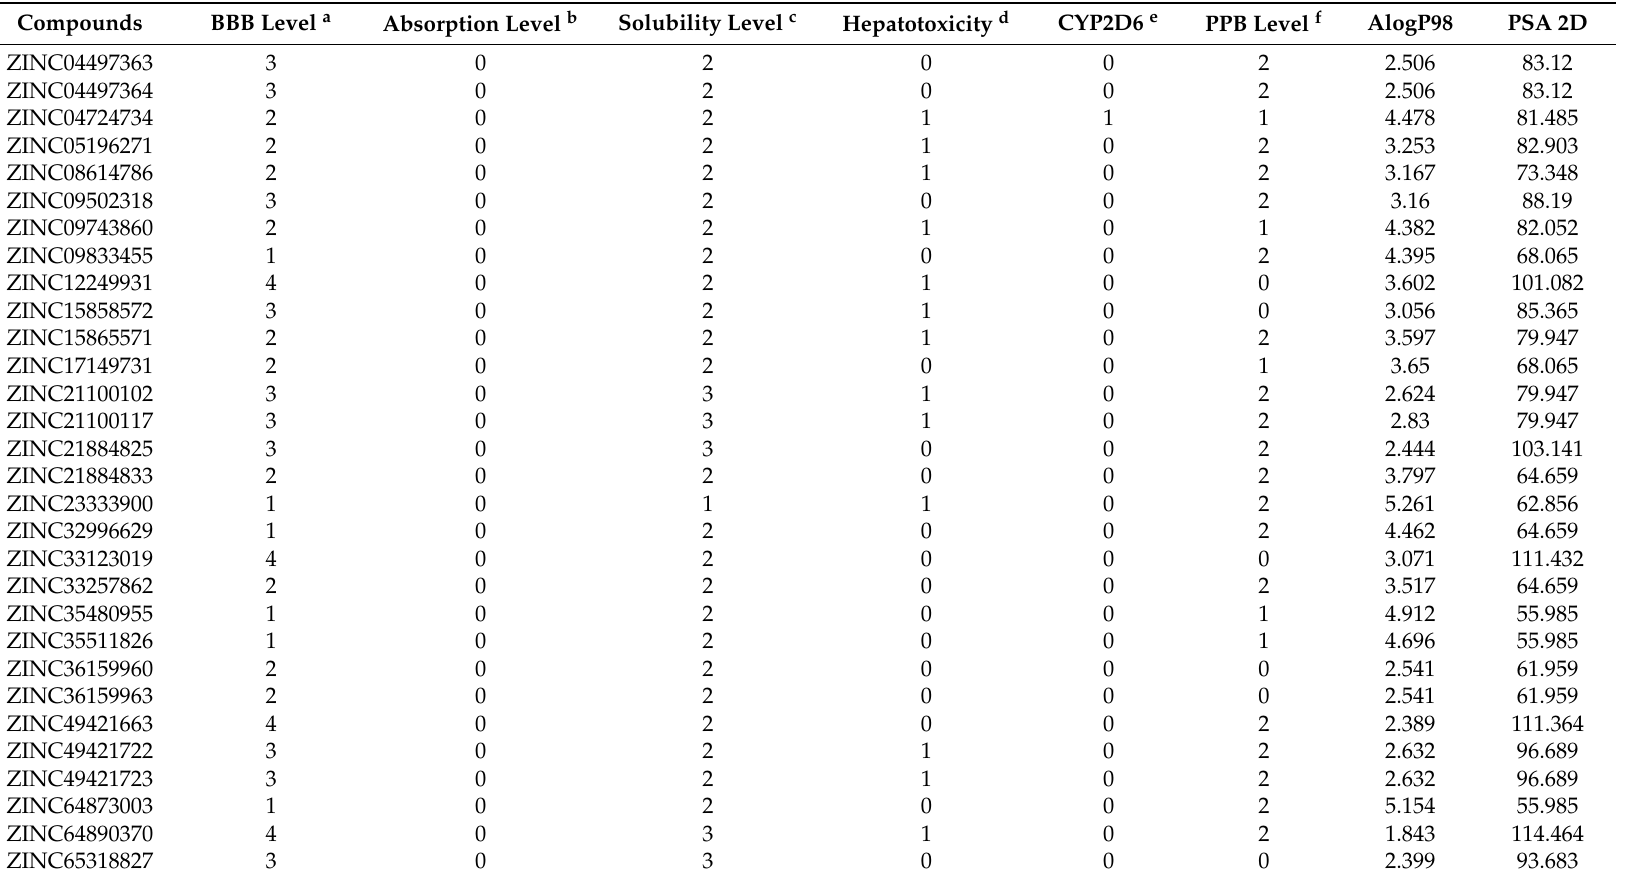
Table 1. The absorption, distribution, metabolism, excretion, and toxicity (ADMET) predictions for 30 selected